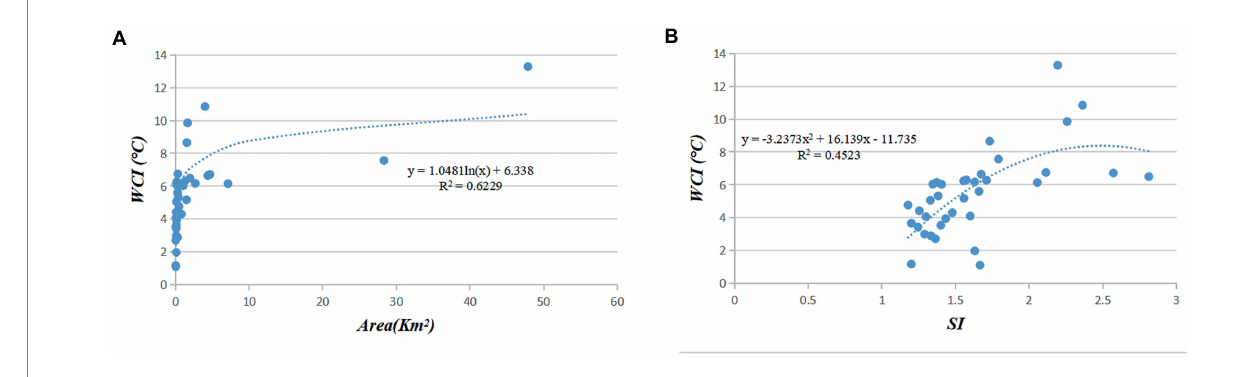
FIGURE 4 Scatterplots and fitting curves between the WCI intensity and (A) the area of water body at the significance level of 0.01 and (B) the shape index of water body at the significance level of 0.05 ( n = 36).